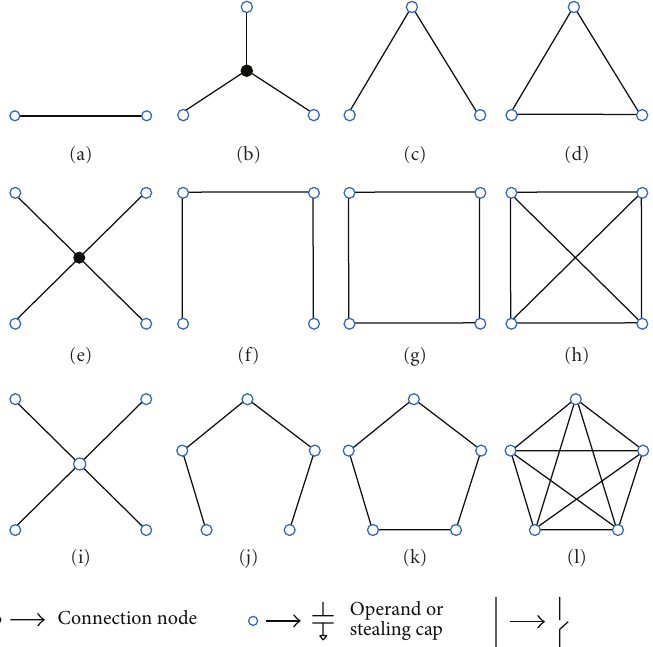
Figure 10: Different switching topologies for charge domain